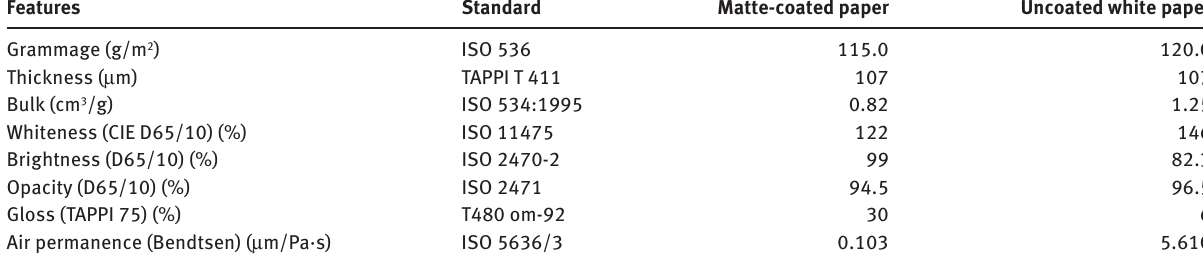
Table 1 Some properties of substrate papers used.